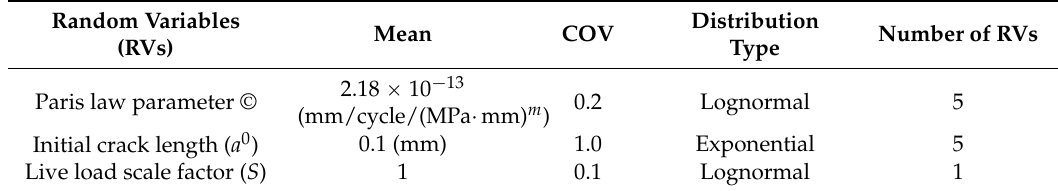
Table 3. Statistical properties of random